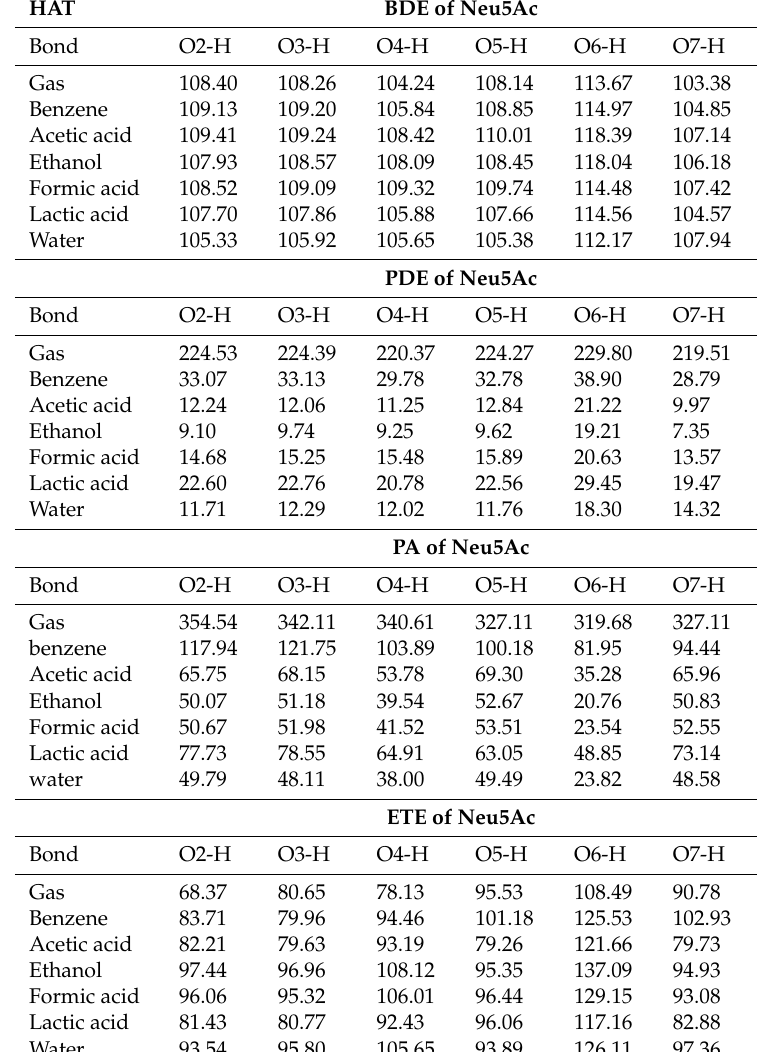
Table 6. Antioxidant mechanism parameters of Neu5Ac. (optimized and thermal correction to enthalpy at the M062X/6-311 + G(d,p) level, Single point energy at the M062X/def2TZVPPD level, kcal/mol).